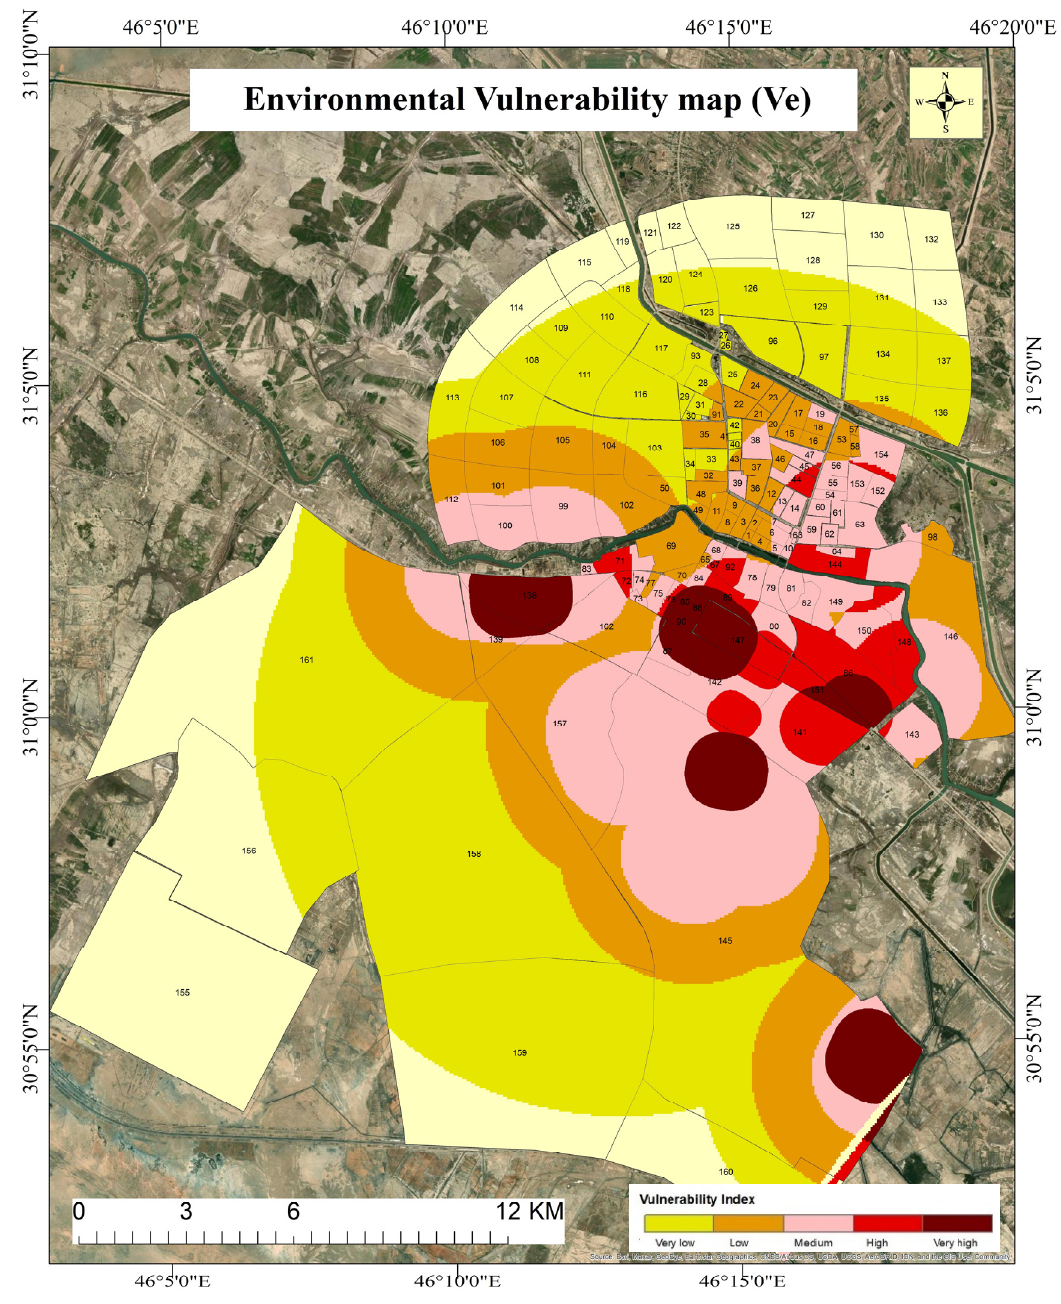
Figure 20. Environmental vulnerability map (Ve).